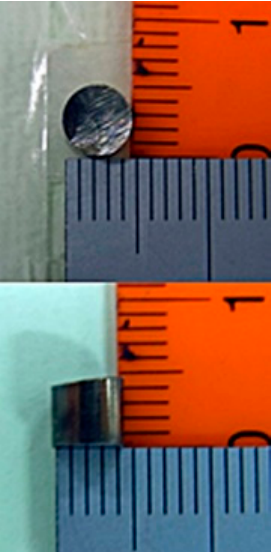
Figure 13. One of the measurement samples made of tool steel.